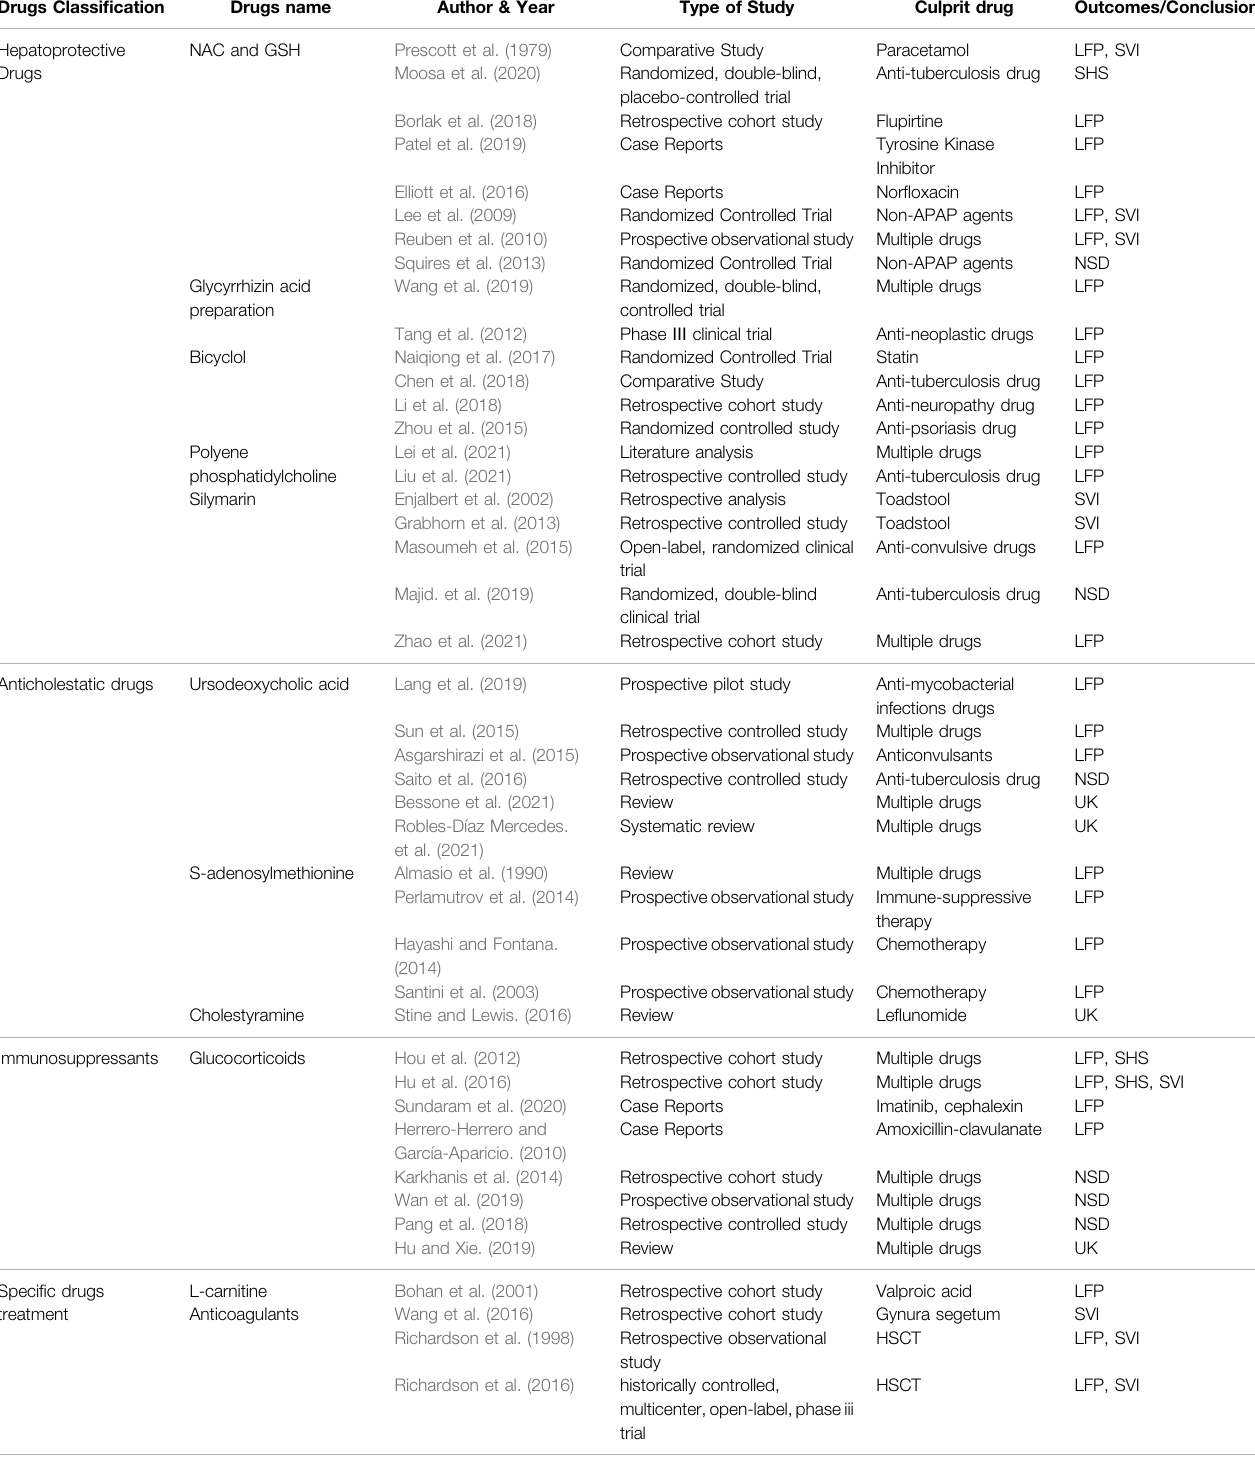
TABLE 2 | Pharmacotherapy strategies of